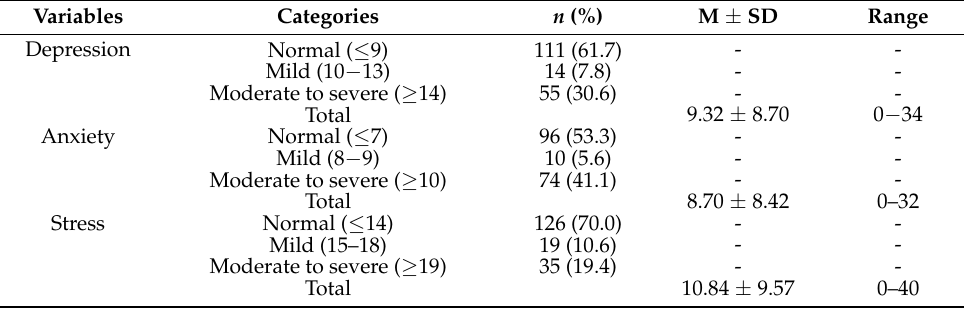
Table 1. Mental health status of participants ( n =